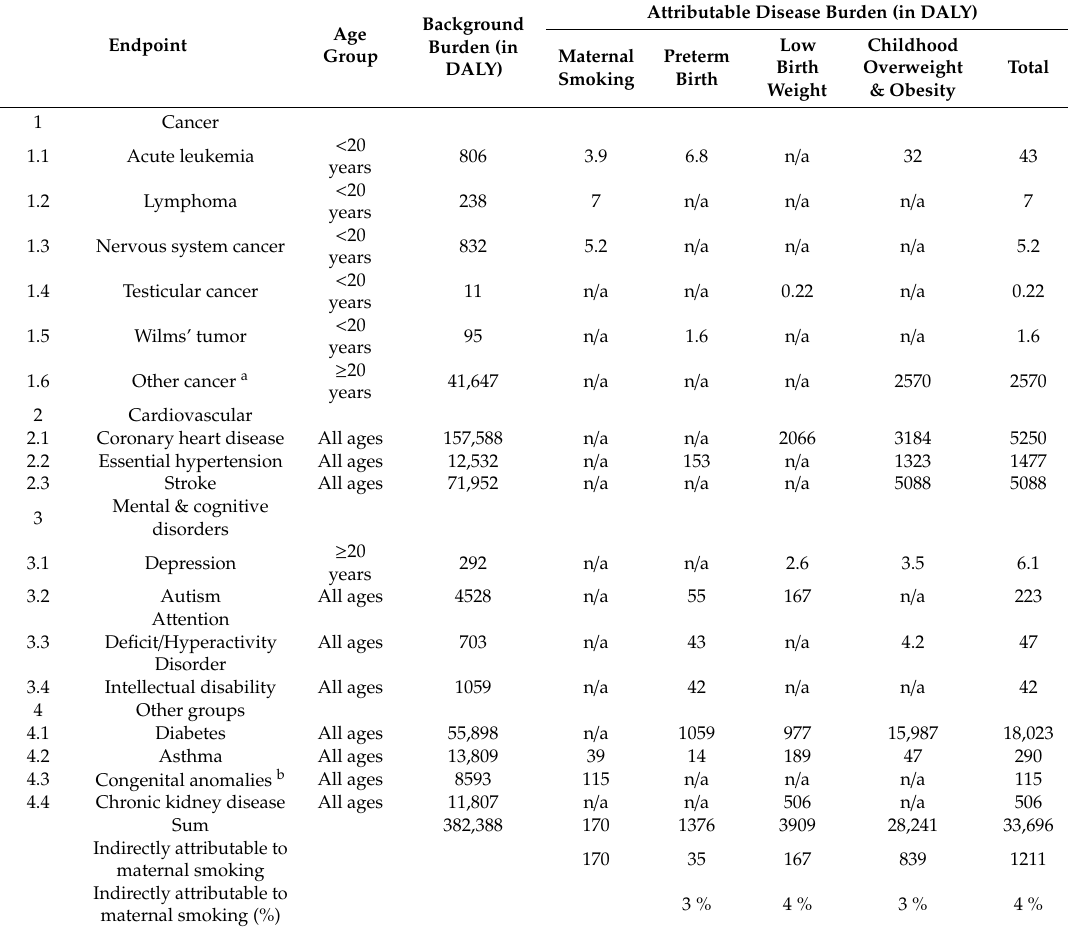
Table 2. Summary of identified endpoints in three umbrella systematic literature reviews and corresponding attributable burden of disease (in